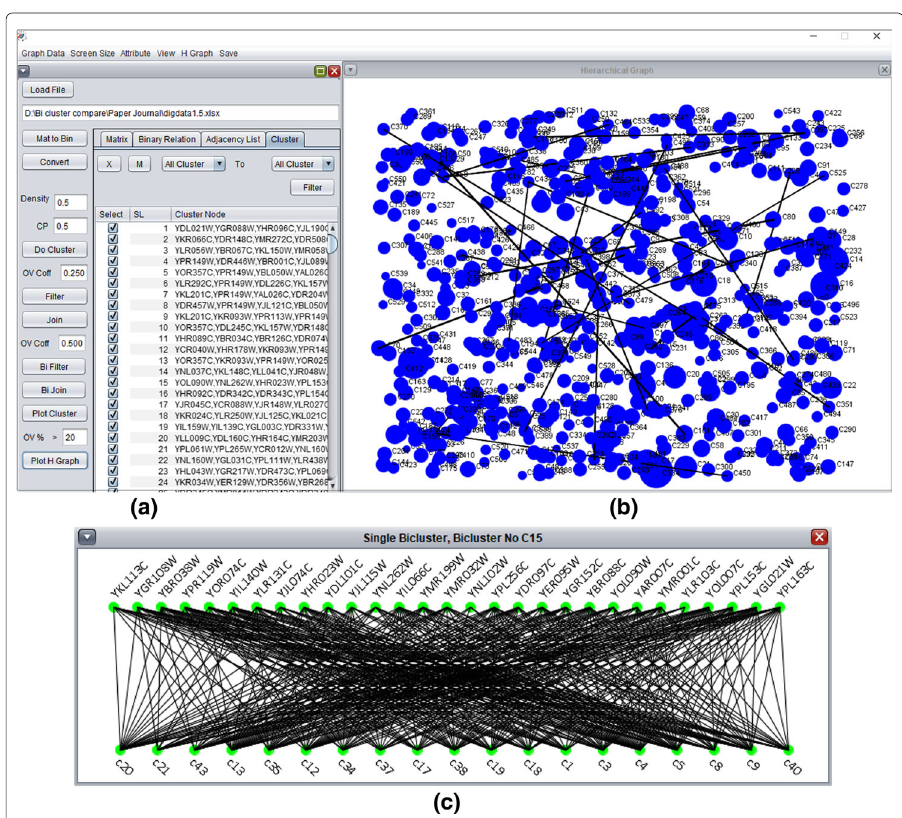
Fig. 2 Implementation of BiClusO a ) tabular format of biclusters b ) hierarchical view of biclusters c ) a single bicluster